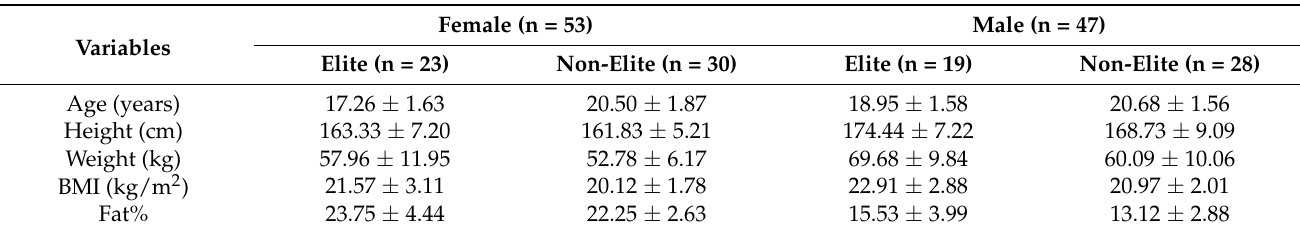
Table 1. Physical characteristics of